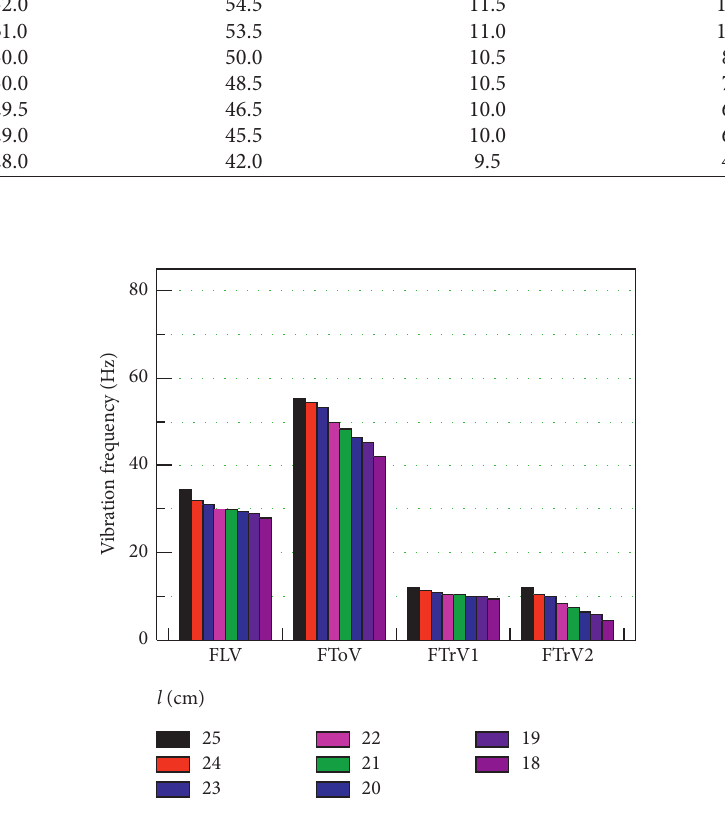
Figure 7: Natural frequency of rock under different vibration